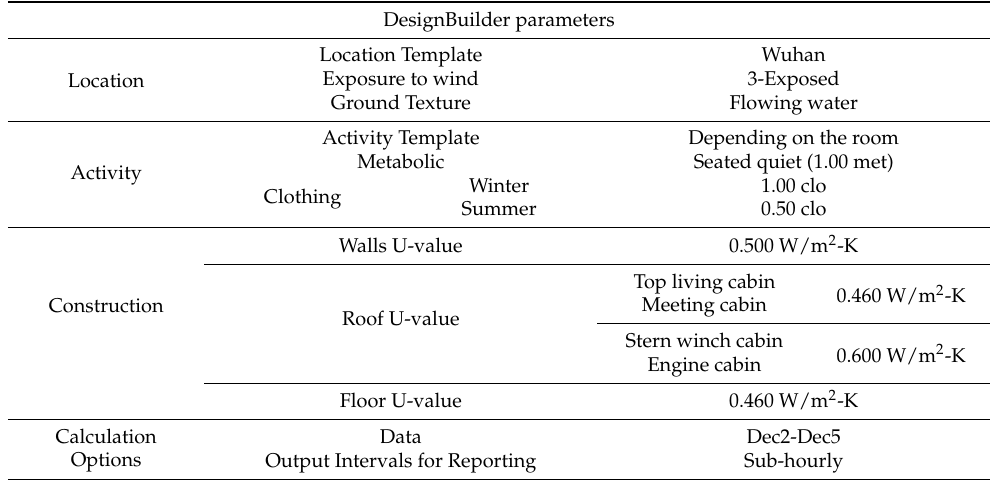
Table 3. DesignBuilder parameter settings.